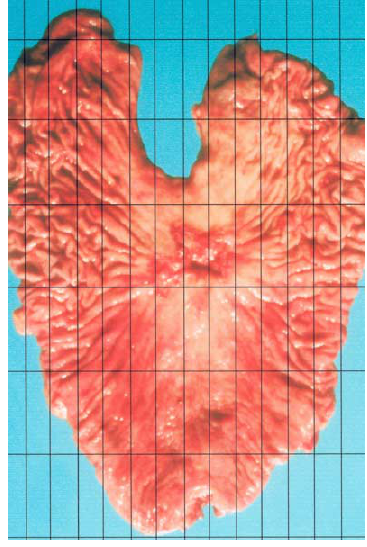
Fig. 1. AGC in the resected specimen prepared for cartography. The lesion is evident in the resected specimen. The tumour containing the surrounding wall was cut into multiple slices parallel to the lesser curvature at interval of 4 to 5